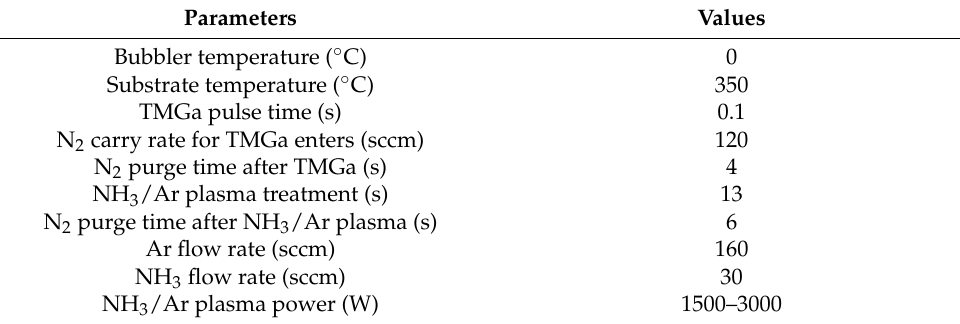
Table 2. Detailed deposition parameters of the GaN